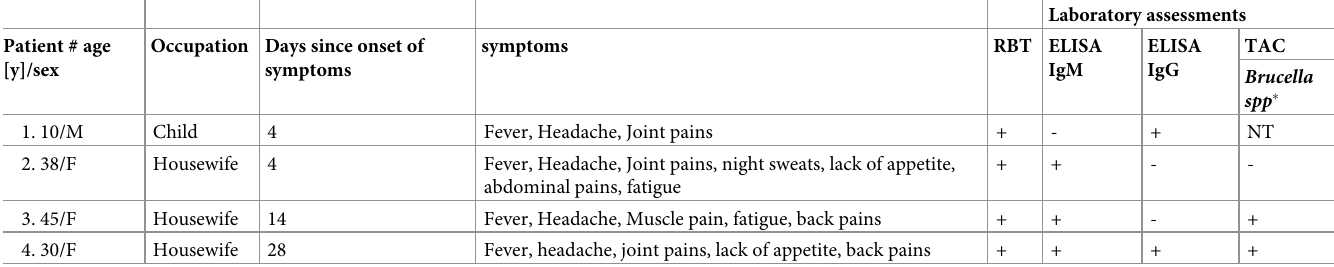
Table 4. Demographic, clinical characteristics and laboratory assessments of confirmed brucellosis cases in Kajiado, Kenya 2015–2016 (n =